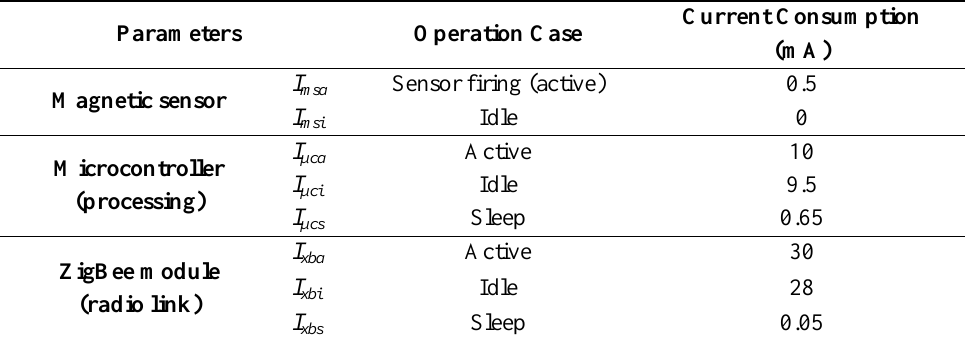
Table 3. Current consumption of various components in the sensor node associated to Equations (6) and (7).